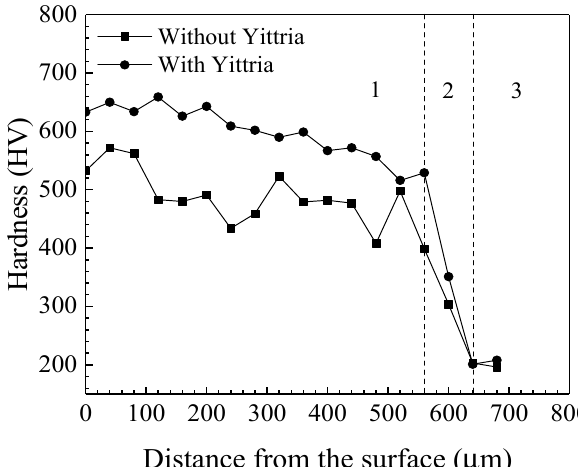
Figure 4. Microhardness distribution ranging from laser cladding coatings to substrate. 1, 2 and 3 denote the laser cladding coating, transition zone and substrate, respectively.